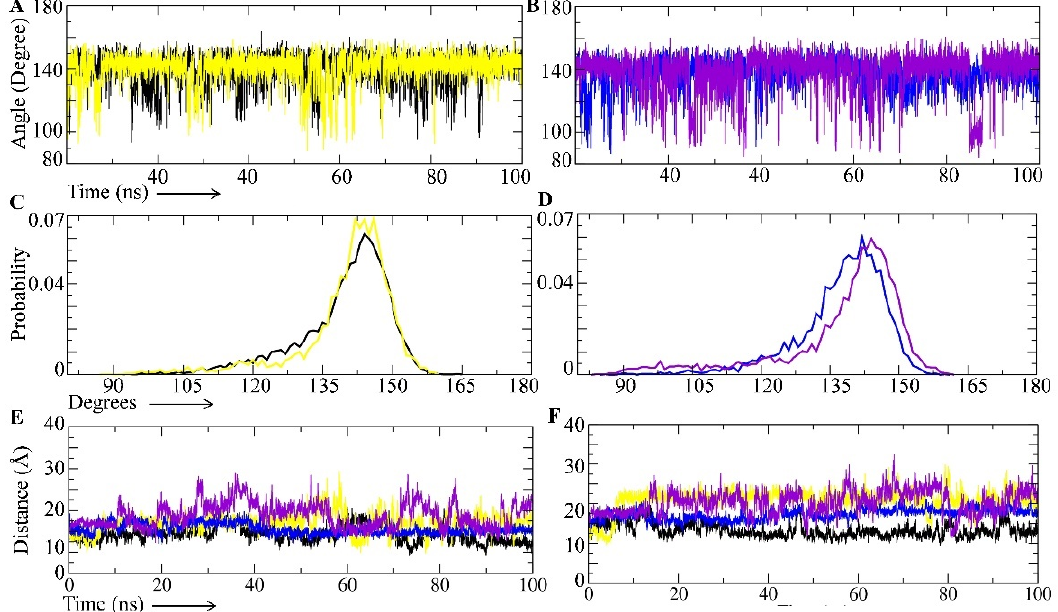
Figure 4. Effect of the M46I mutation on flap curling and the open/semi-open/close conformations of saquinavir-bound HIV-1 protease. The TriCa angle (Gly48–Gly49–Ile50 amino acid residues) distance in ( A ) Saquinavir-unbound wild-type/mutated structure and ( B ) Saquinavir-bound wild-type/mutated structure during the 100 ns simulation period. The TriCa angle degree probability in ( C ) Saquinavir-unbound wild-type/mutated structure and ( D ) Saquinavir-bound wild-type/mutated structure. Fluctuation in the ( E ) Asp25-Ile50 and ( F ) Asp25-Ile149 distances in wild-type, saquinavir-bound wild-type, M46I-mutation-carrying protease, and saquinavir-bound mutation-carrying protease during the simulation period. The black, blue, yellow, and purple colors represent the wild-type, saquinavir-bound wild-type, M46I-mutation-carrying protease, and saquinavir-bound mutation-carrying protease systems, respectively.